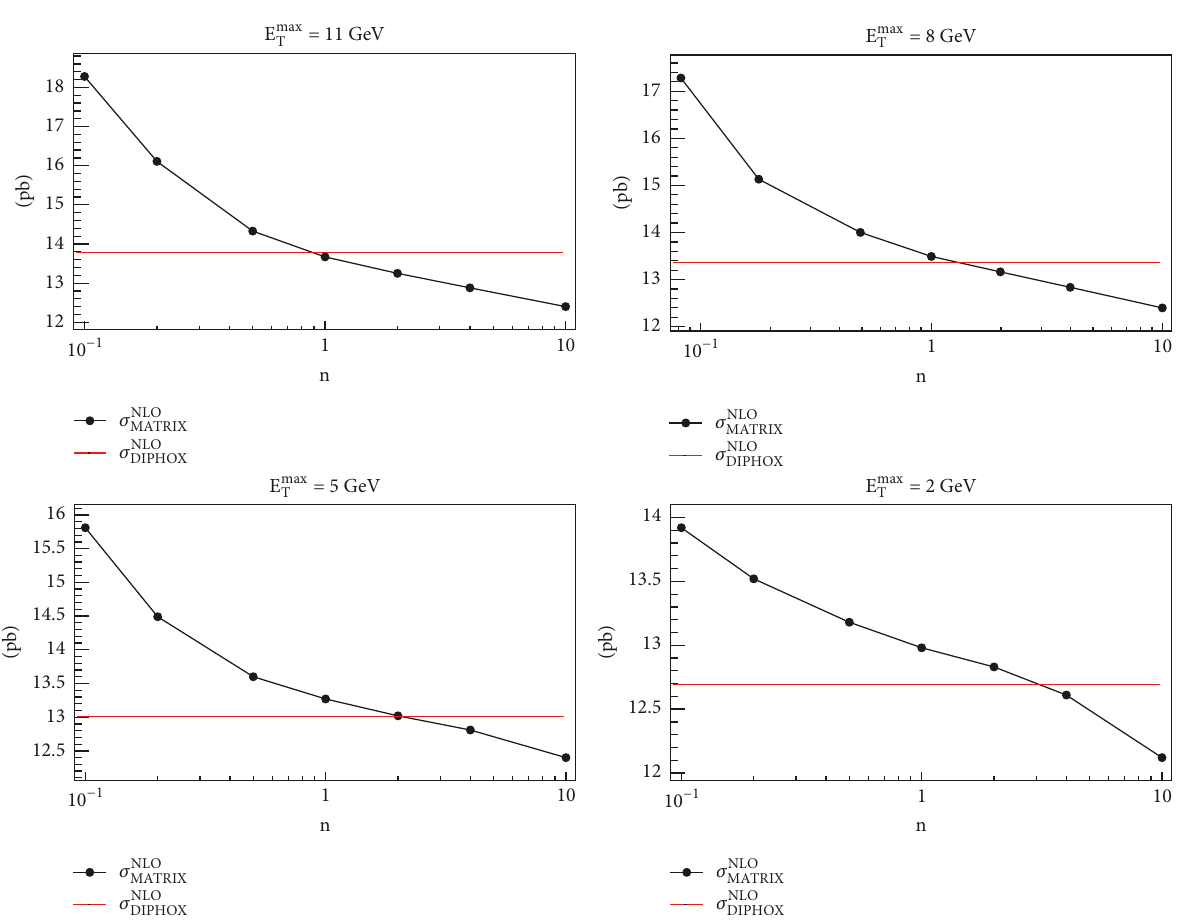
Figure 2: The MATRIX and the DIPHOX integrated fiducial cross-section 𝜎 𝑁𝐿𝑂 𝑡𝑜𝑡 as a function of the parameter 𝑛 related to Frixione isolation criterion (see (5)) for several values of 𝐸 max 𝑇 . The “central values” of the parameter 𝑛 = 𝑛 0 depend on the value of 𝐸 max 𝑇 ; they are reported